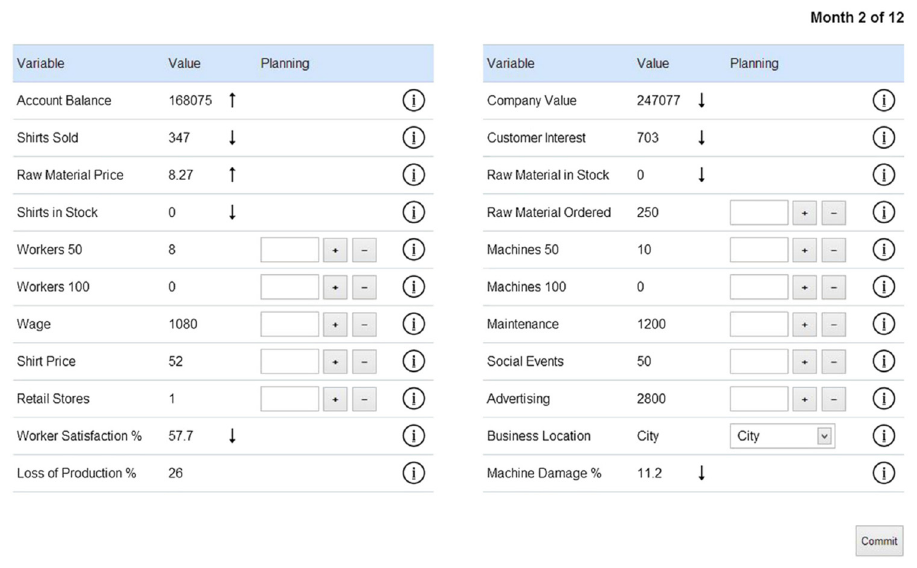
Figure 1. Screenshot of the Tailorshop’s graphical interface. Note the arrows indicating changes in the variables compared to the previous month.